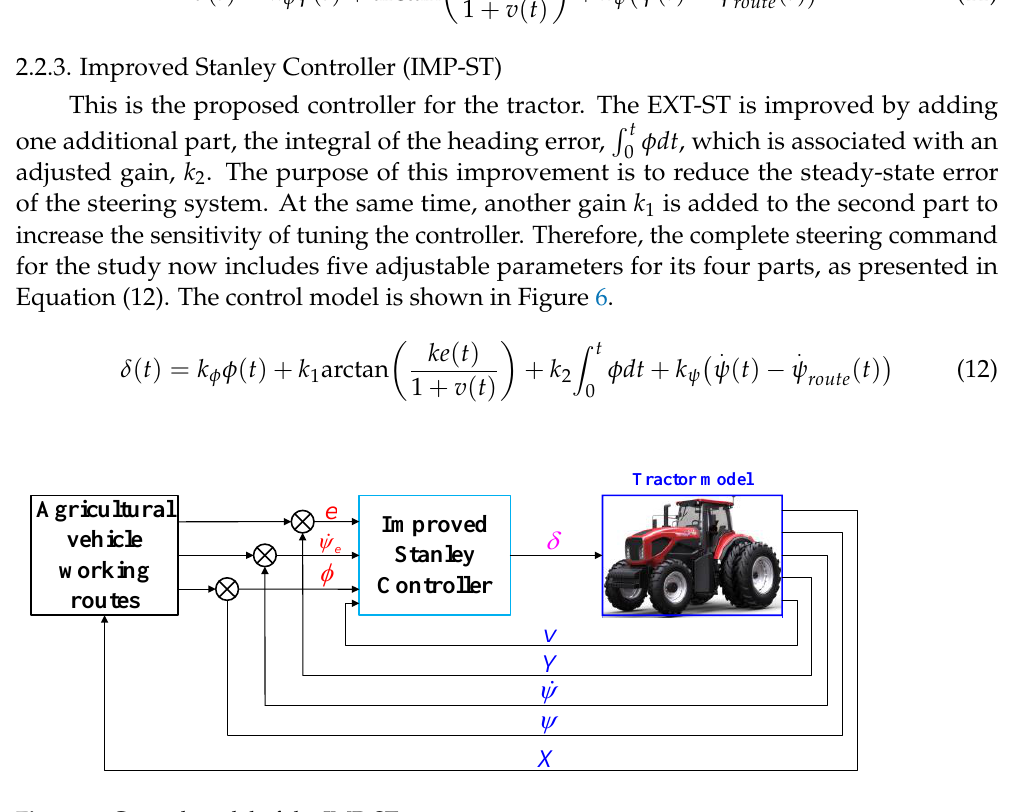
Figure 6. Control model of the IMP-ST.